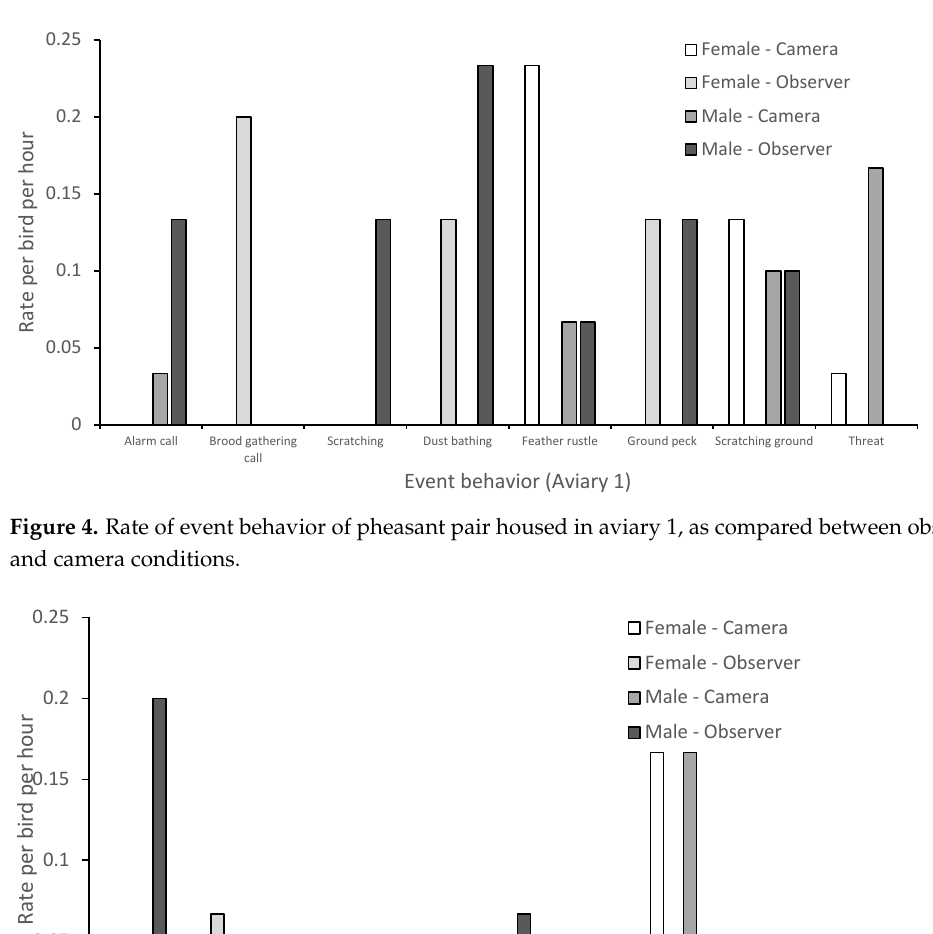
Figure 3. State behavior of pheasant pair housed in aviary 2 (+/ − standard deviation), as compared between observer and camera conditions.